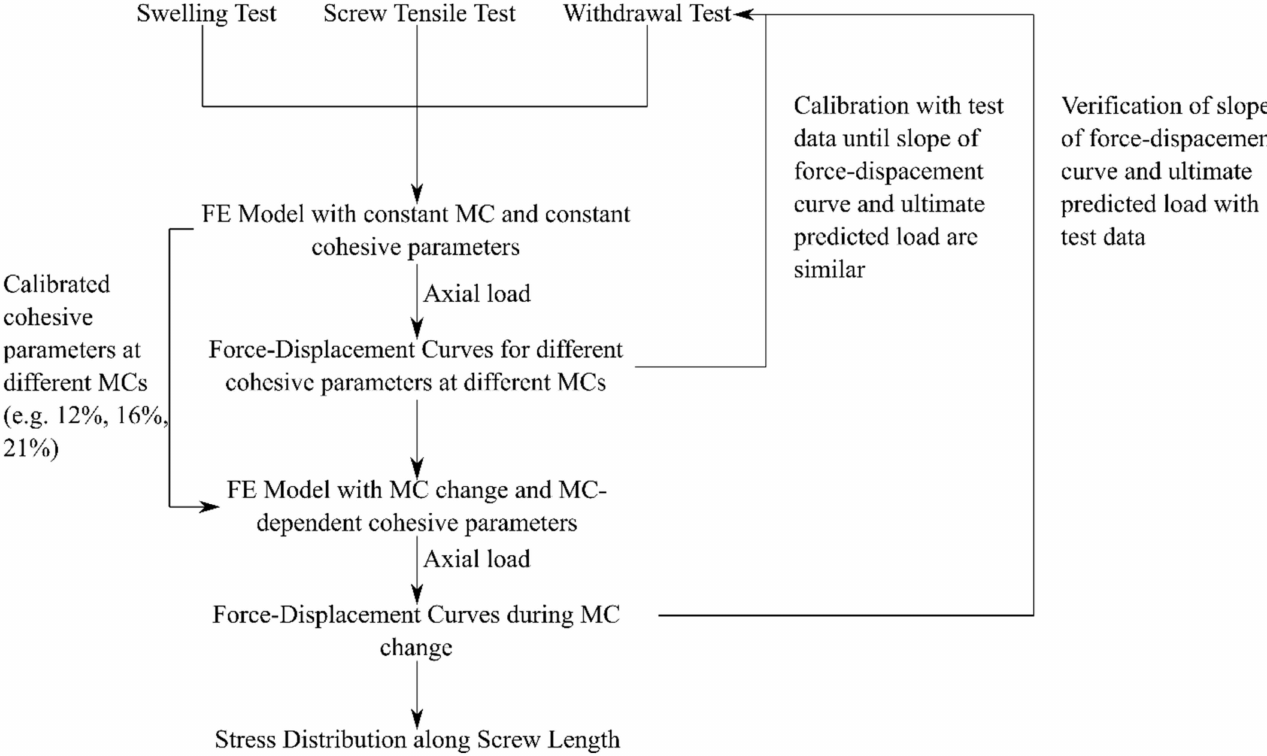
Figure 14. Finite element model calibration and verification